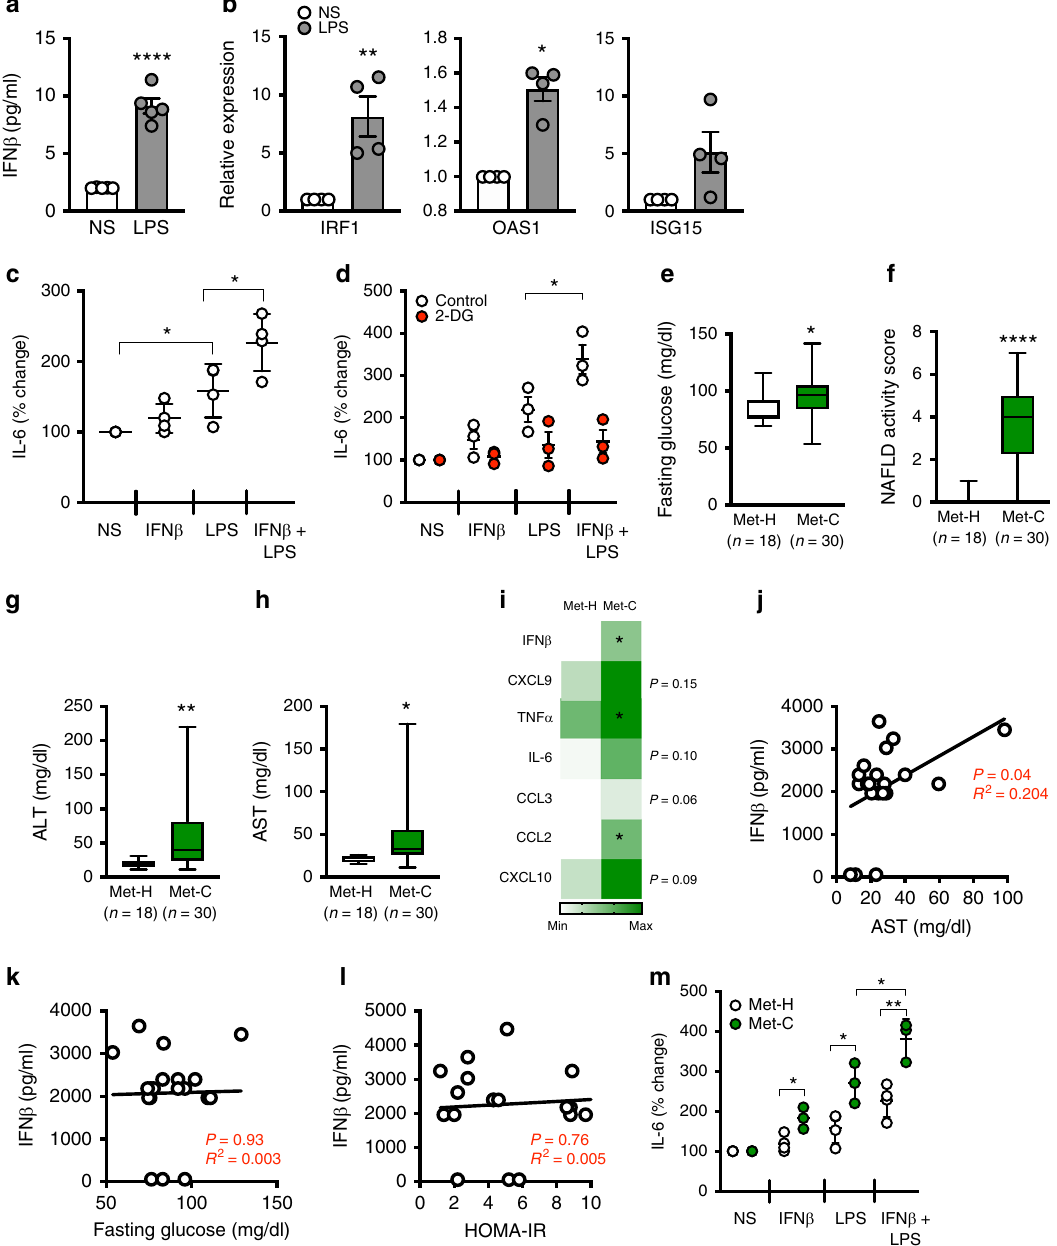
Fig. 7 Type I IFN axis effects on adipocyte in fl ammatory vigor are conserved in humans. a − d Human primary adipocytes were isolated from omental adipose tissue of metabolically health obese (Met-H) individuals. Adipocytes were subsequently treated with saline (NS), human IFN β (250 U/ml) or LPS (100 ng/ml) as indicated. a Quanti fi ed supernatant IFN β protein by ELISA. b mRNA expression of indicated type I IFN axis genes by qPCR, relative expression to NS. c IL-6 protein levels quanti fi ed in supernatant by ELISA; % change over NS. d Quanti fi ed IL-6 protein levels in supernatant of adipocytes treated in the presence or absence of 2-DG (2 μ M) by ELISA, % change over NS. e − m Persons with severe obesity were strati fi ed into Met-H or metabolically challenged (Met-C) groups. e Fasting glucose. f NAFLD activity score. g ALT. h AST. i Average systemic protein levels of indicated cytokines and chemokines quanti fi ed by Luminex. j Systemic IFN β levels correlated with AST. k Systemic IFN β correlated with fasting glucose. l Systemic IFN β correlated with HOMA-IR. m IL-6 protein levels quanti fi ed in adipocyte supernatant by ELISA, % change over NS. a − d Representative patients, n = 3 − 5/ condition. e , f Data combined of representative patients, n = 18 Met-H and n = 30 Met-C. i Data combined of representative patients, n = 11 Met-H and n = 12 Met-C. j − l Data combined of representative patients, n = 19. m Representative patients, n = 3 − 4/condition. a , b , i For bar graphs and heat maps, data represent mean ± SEM. c − h , m For box plots, the midline represents the mean, boxes represent the interquartile range and whiskers show the full range of values. a − i , m Unpaired two-tailed Student ’ s t test. * P < 0.05, ** P < 0.01, **** P < 0.0001. j − l Linear regression analysis. Source data are provided as a Source data fi